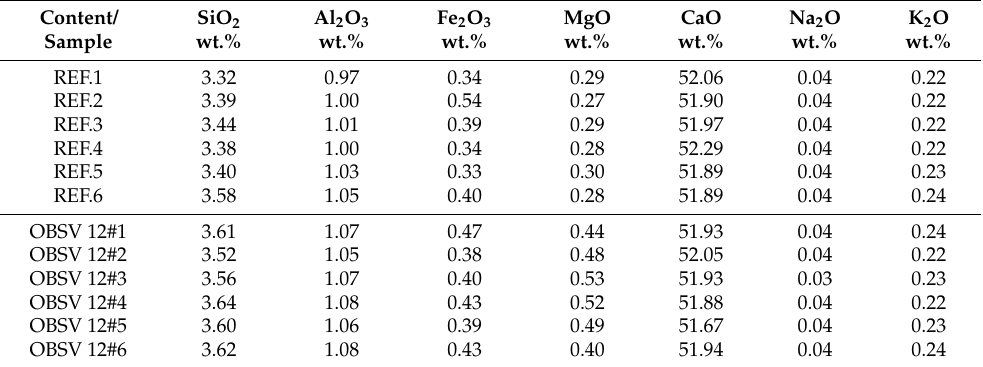
Table 1. Bulk chemical composition of unflooded reference samples including the end piece of the flooded sample which has not been flooded (REF.6) and the flooded chalk samples of OBSV 12. Analysis with HIM-SIMS was performed on OBSV 12.4. wt.% indicates weight percent. The complete data set is available in Supplementary Table